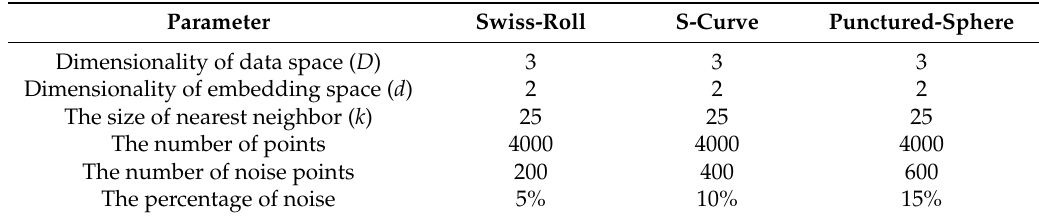
Table 1. Parameter settings of the LLE and M-LLE experiments reported in Figure 4. Parameter Swiss-Roll S-Curve Punctured-Sphere Dimensionality of data space ( D )